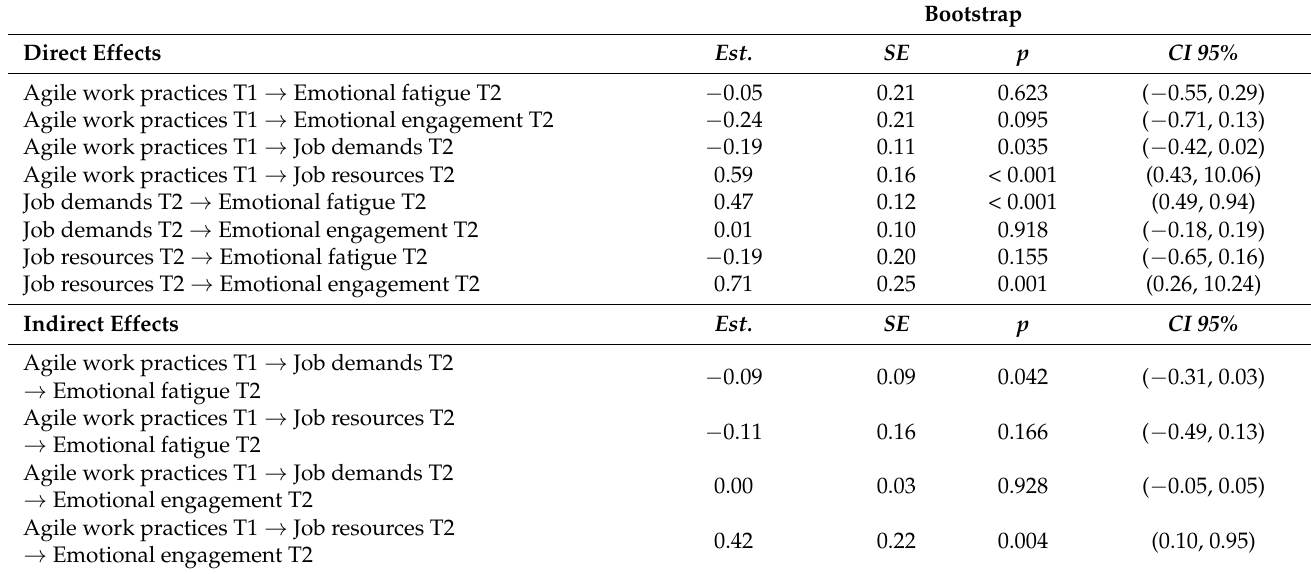
Table 2. Direct and indirect effects using bootstrapping (10,000